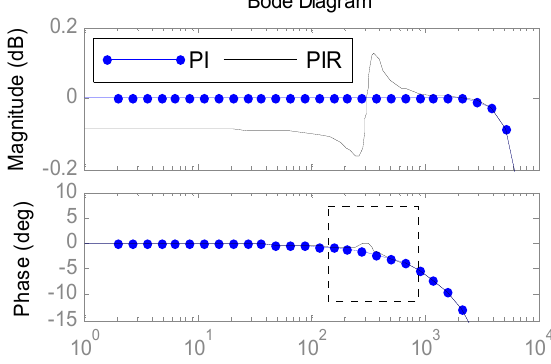
Figure 15. Bode diagram for open-loop. Frequency (rad/sec). Appl. Sci. 2018 , 8 , x FOR PEER REVIEW